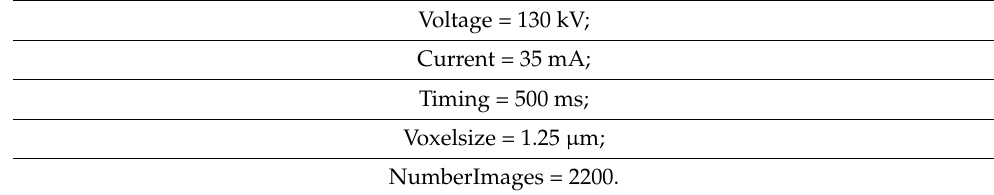
Table 4. CT scanning parameters..